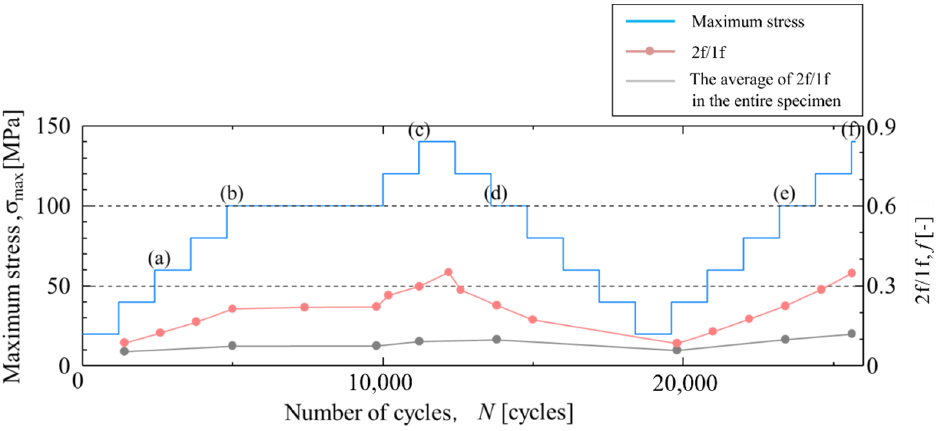
Figure 16. Change in 2f/1f in staircase-like stress level test in Area c-2. The letters ( a )–( f ) indicates the measurement timing shown in Figure 15.